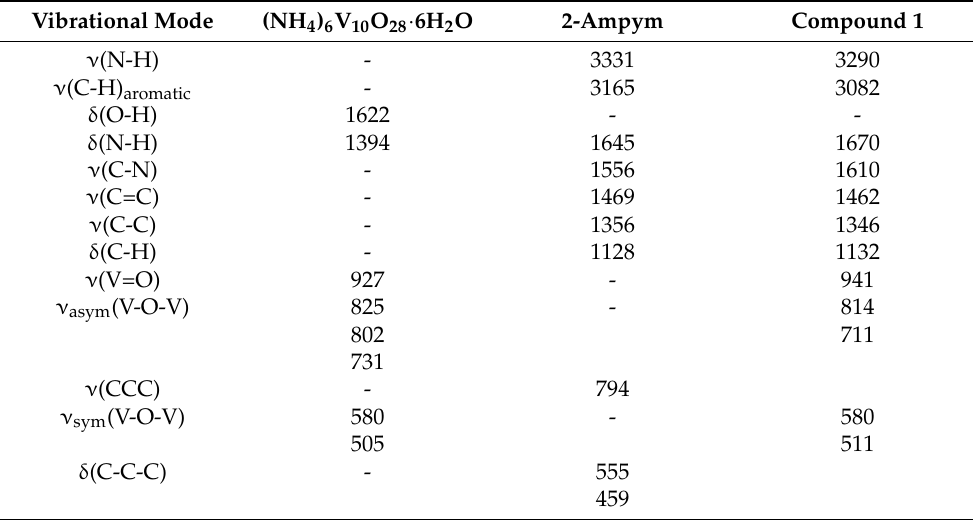
Figure 6. IR spectra of ammonium decavanadate, 2-aminopyrimidine ligand, and Compound 1 in the range 4000–400 cm − 1 at room temperature. Table 4. IR bands (cm − 1 ) of ammonium decavanadate, 2-aminopyrimidine ligand (2-ampym),